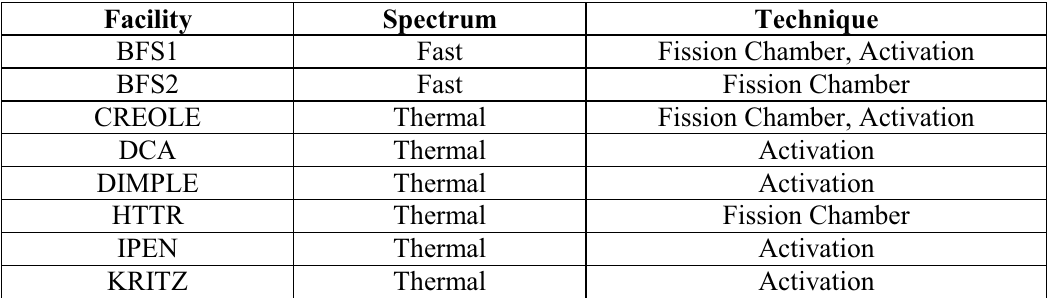
Table VII.: Reaction rate distribution experimental benchmarks in the IRPhEP